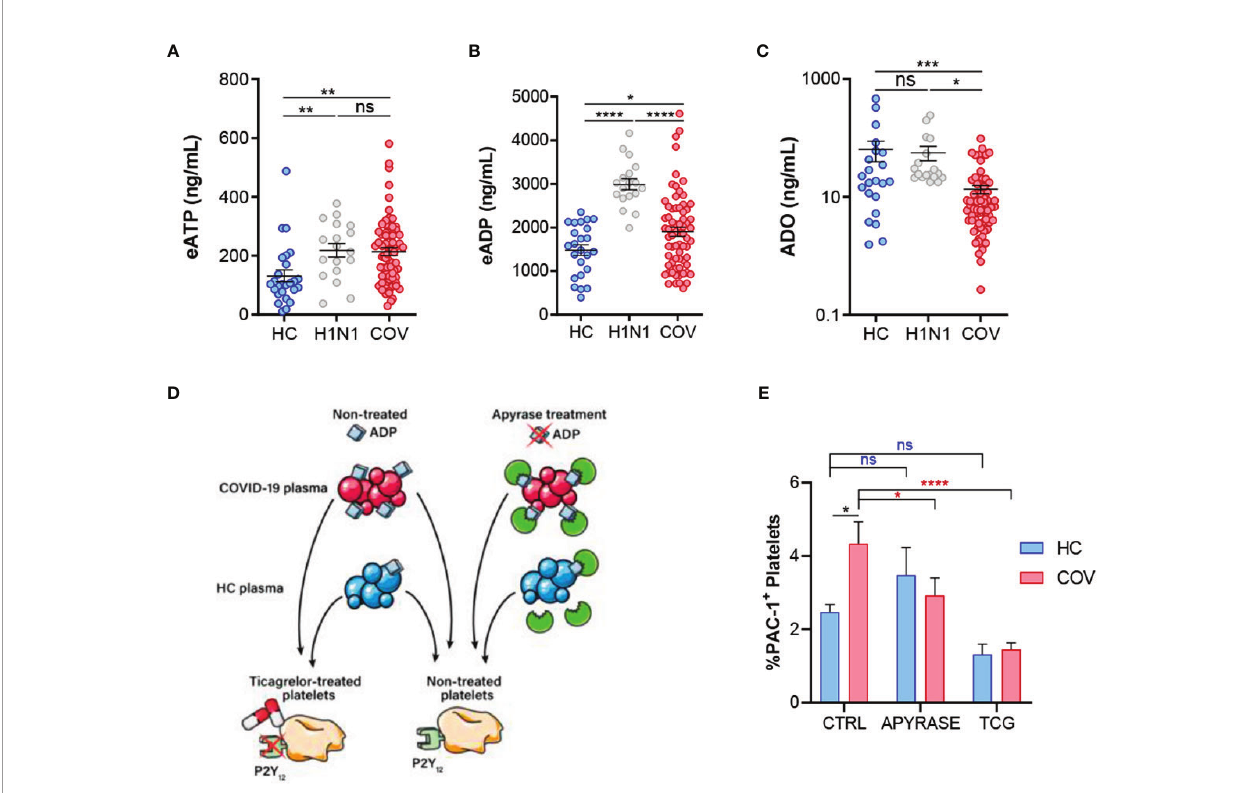
FIGURE 4 | Purinergic nucleotides dysregulation and its possible role in platelet activation. (A) ELISA quanti fi cation of eATP plasma levels in healthy controls (HC, n=26), in fl uenza A patients (H1N1, n=18) and COVID-19 patients (COV, n=70). (B) ELISA quanti fi cation of eADP in the study groups (HC, n=24; H1N1, n=18; COV, n=69. (C) ELISA quanti fi cation of ADO plasma levels in the study groups (HC, n=22; H1N1, n=18; COV, n=70). Mean differences were analyzed using unpaired Student t-test analysis with Welch correction (D) Graphic representation of in vitro model of platelet activation. (E) Flow cytometry determination of platelet activation by PAC-1 signal. Platelets were treated with healthy control plasma (blue, n=8) or COVID-19 patients ’ plasma (red, n=15) under three different conditions: control (CTRL: non-treated plasmas and non-treated platelets); apyrase (APYRASE: pretreated plasmas with apyrase 0·2U/mL for 20 minutes); ticagrelor (TCG: pretreated platelets with ticagrelor 20 m M for 20 minutes). Mean differences were analyzed through two-way ANOVA analysis and Sidak ’ s multiple comparison test. Error bars: mean ± SEM. *P < 0·05; **P < 0·01; ***P < 0·001; ****P < 0·0001. ns, non signi fi